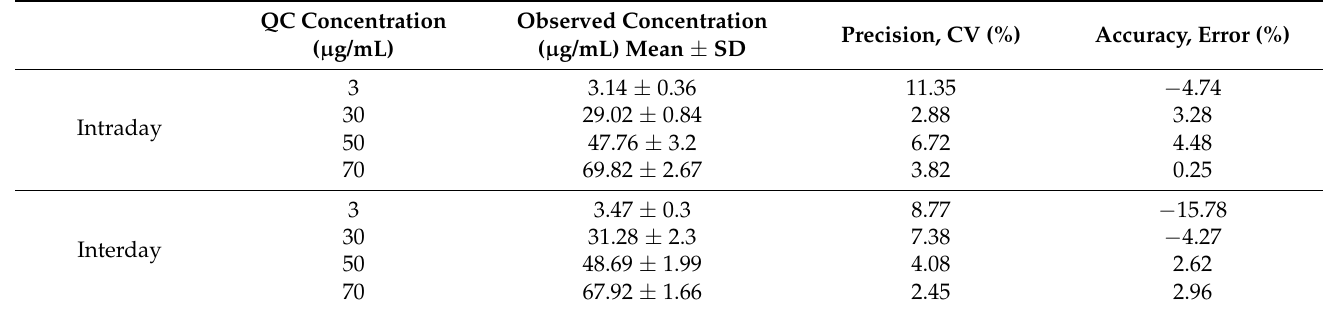
Table 1. Method inter- and intra-day precision (%CV) and accuracy (% error) for Levetiracetam. QC Concentration